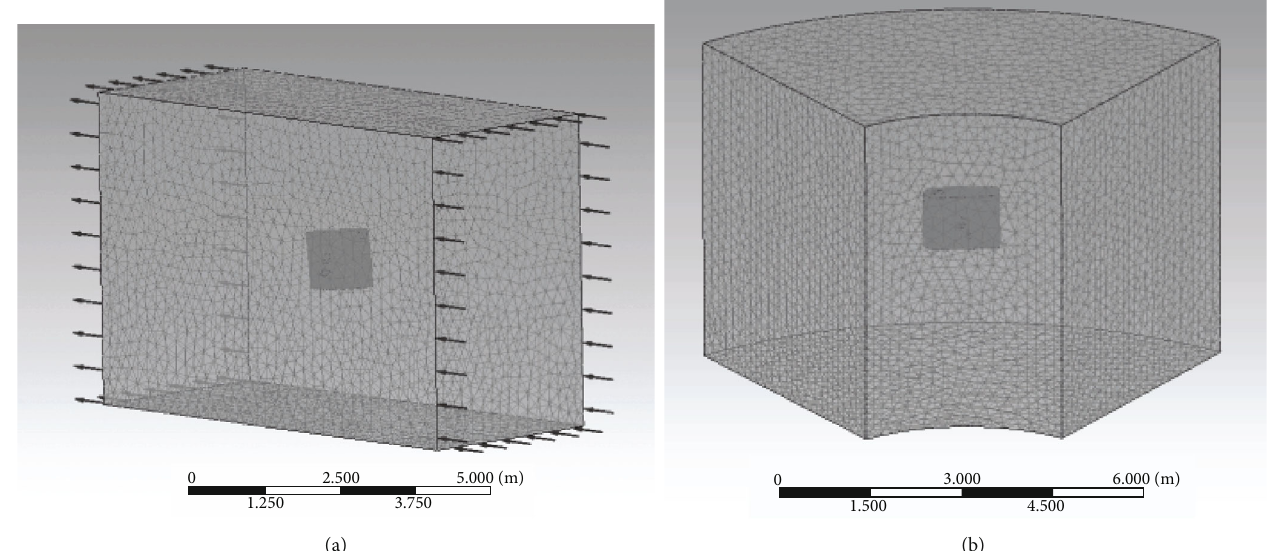
Figure 3: Mesh: (a) mesh for the tow-tank test; (b) mesh for the rotating arm